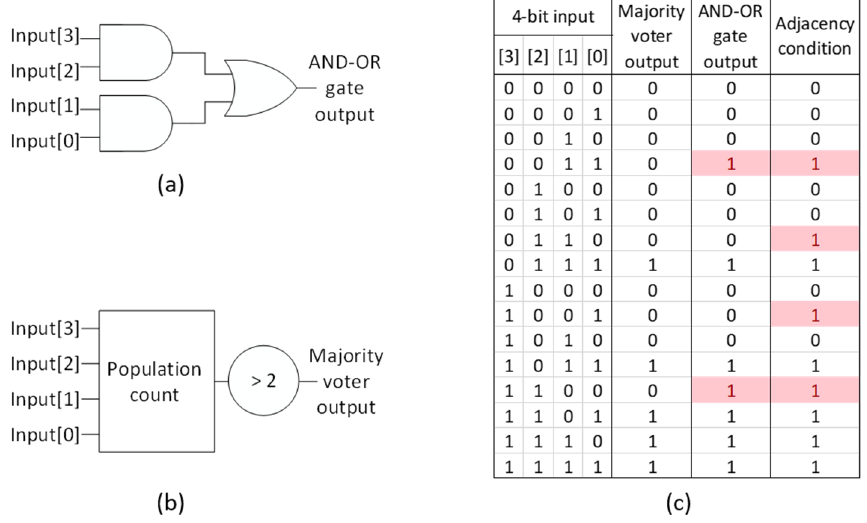
Figure 4. AND-OR pattern detector versus 4-bit majority